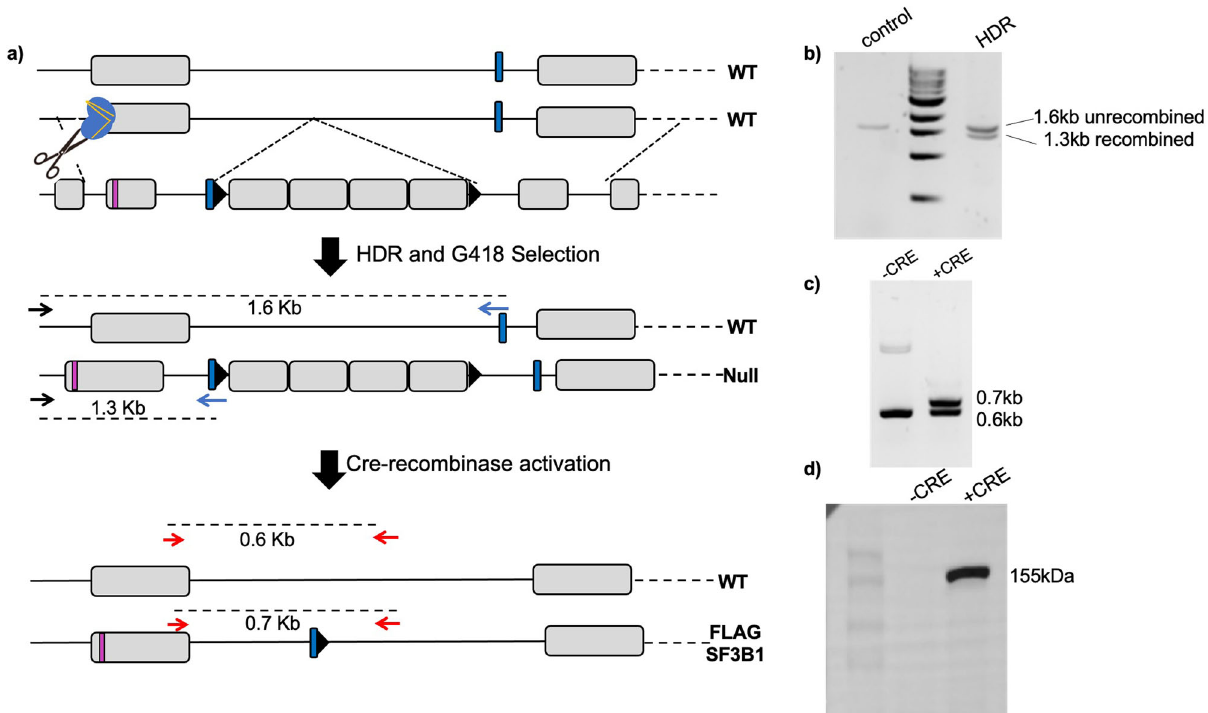
Fig. 5 Single-allele epitope tagging of SF3B1 using CRISPR/AAV in HeLa cells. a Schematic of genomic SF3B1 locus and rAAV vector is shown. AAV vector consists of left homology arm (LHA) with FLAG-tag and extra 20 bp from downstream exons added to the end for PCR screening, neomycin cassette with IRES, poly(A) termination signal, and a right homology arm (RHA). LoxP sites (shown by black triangles) were placed as indicated to excise out the neomycin cassette after recombination was con fi rmed. Initially a null allele is formed due to termination of transcript at the p(A) signal following the Neo R cassette. Cre recombination leads to elimination of the cassette fl anked by two LoxP sequences and the FLAG-tagged allele is expressed again, with a FLAG tag at N-terminus. b PCR analysis of genomic DNA isolated from unedited and edited K562 cells that underwent recombination. c PCR analysis of genomic DNA from edited K562 cells pre- and post-Cre activation. d Con fi rmation of successful FLAG-tagged SF3B1 by western blot with FLAG